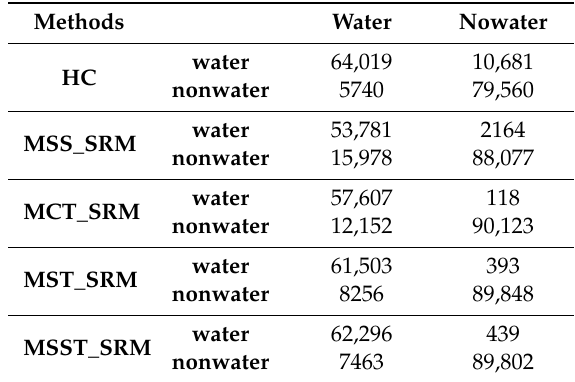
Table 1. Confusion matrices of the di ff erent methods for Tibet Plate Lake.